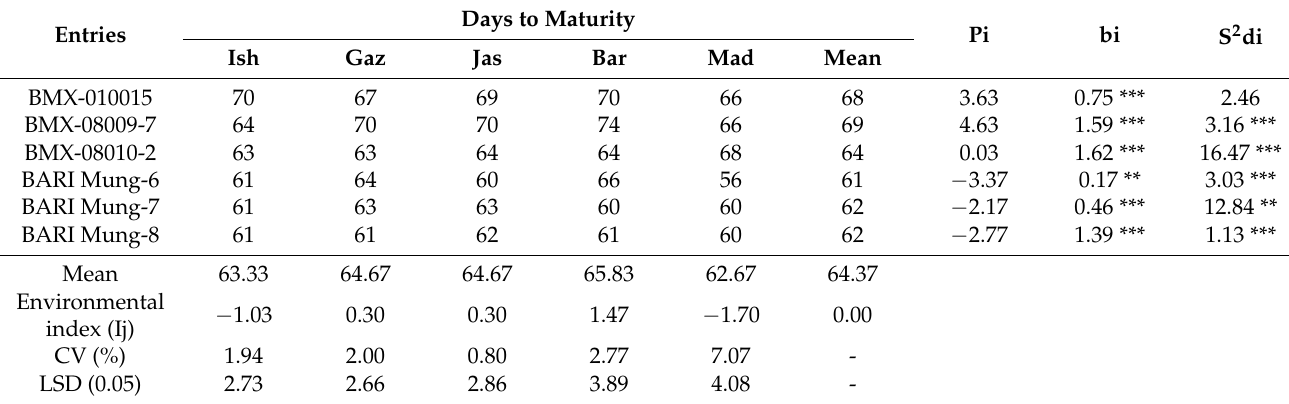
* = Significant at p ≤ 0.05; ** = Significant at p ≤ 0.01; *** = Significant at p ≤ 0.001; Ish = Ishurdi; Gaz = Gazipur; Jas = Jashore; Bar = Barishal; Mad = Madaripur; CV = Coefficient of variation; LSD = Least significant difference, Pi = Phenotypic index; bi = Regression coefficient; S 2 di = Deviation from regression. Table 5. Performance of mung bean genotypes for days to maturity at different environments during summer (Kharif-I) season, 2019.